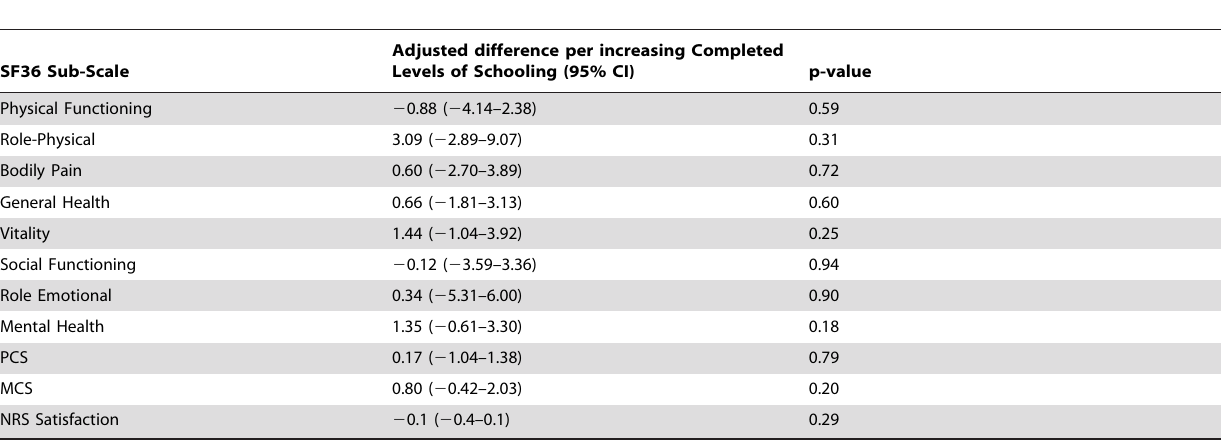
Table 6. Adjusted Difference in Improvement in Health-Related Quality of Life and Satisfaction after Hip Replacement: A Comparison Between Patients with different Completed Levels of Schooling.